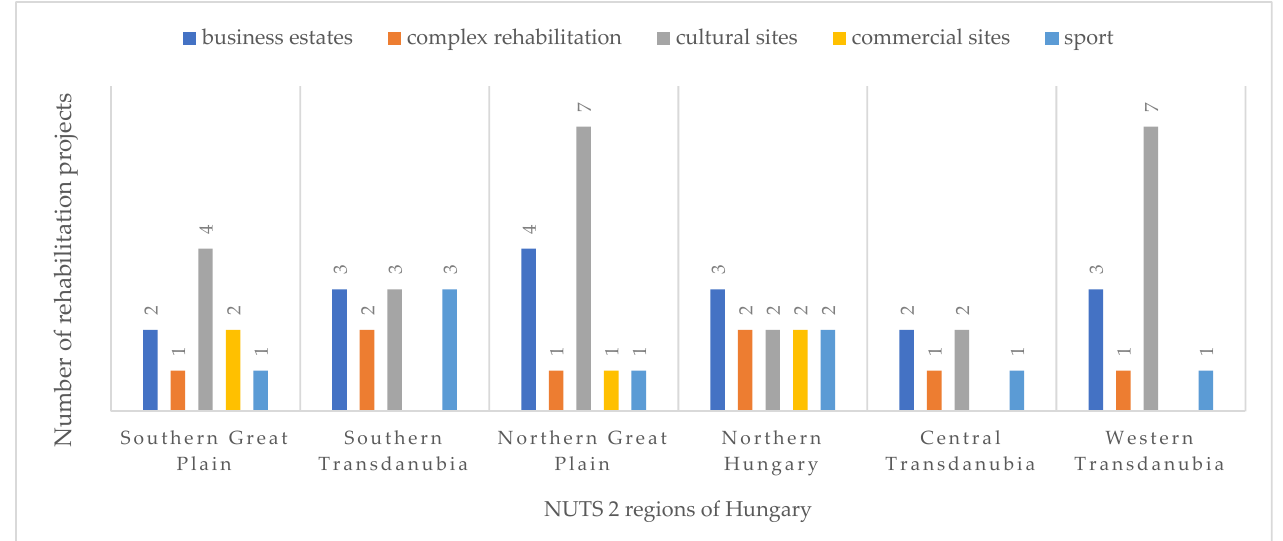
Figure 2. Total number of brownfield rehabilitation projects on NUTS 2 level (N = 64).